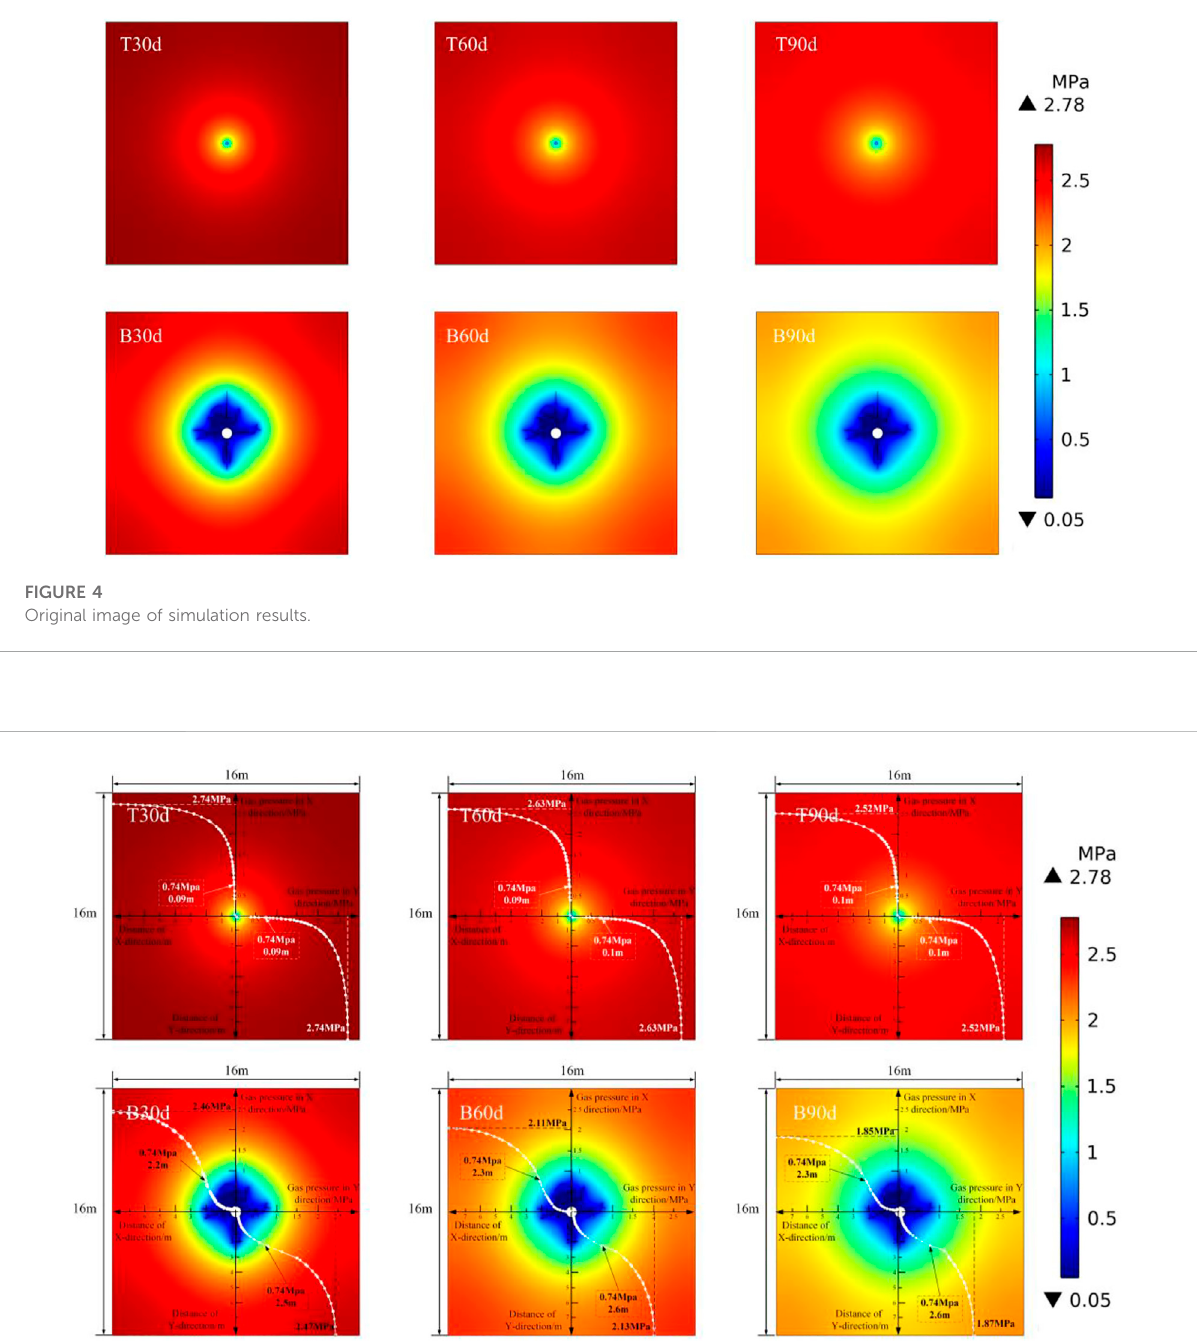
FIGURE 5 Simulation result analysis